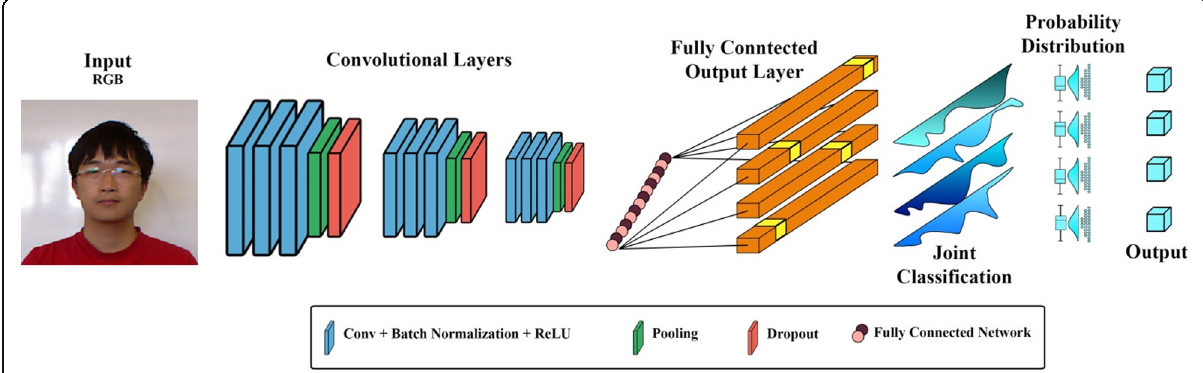
Fig. 2 Schematic illustrations of the proposed face recognition